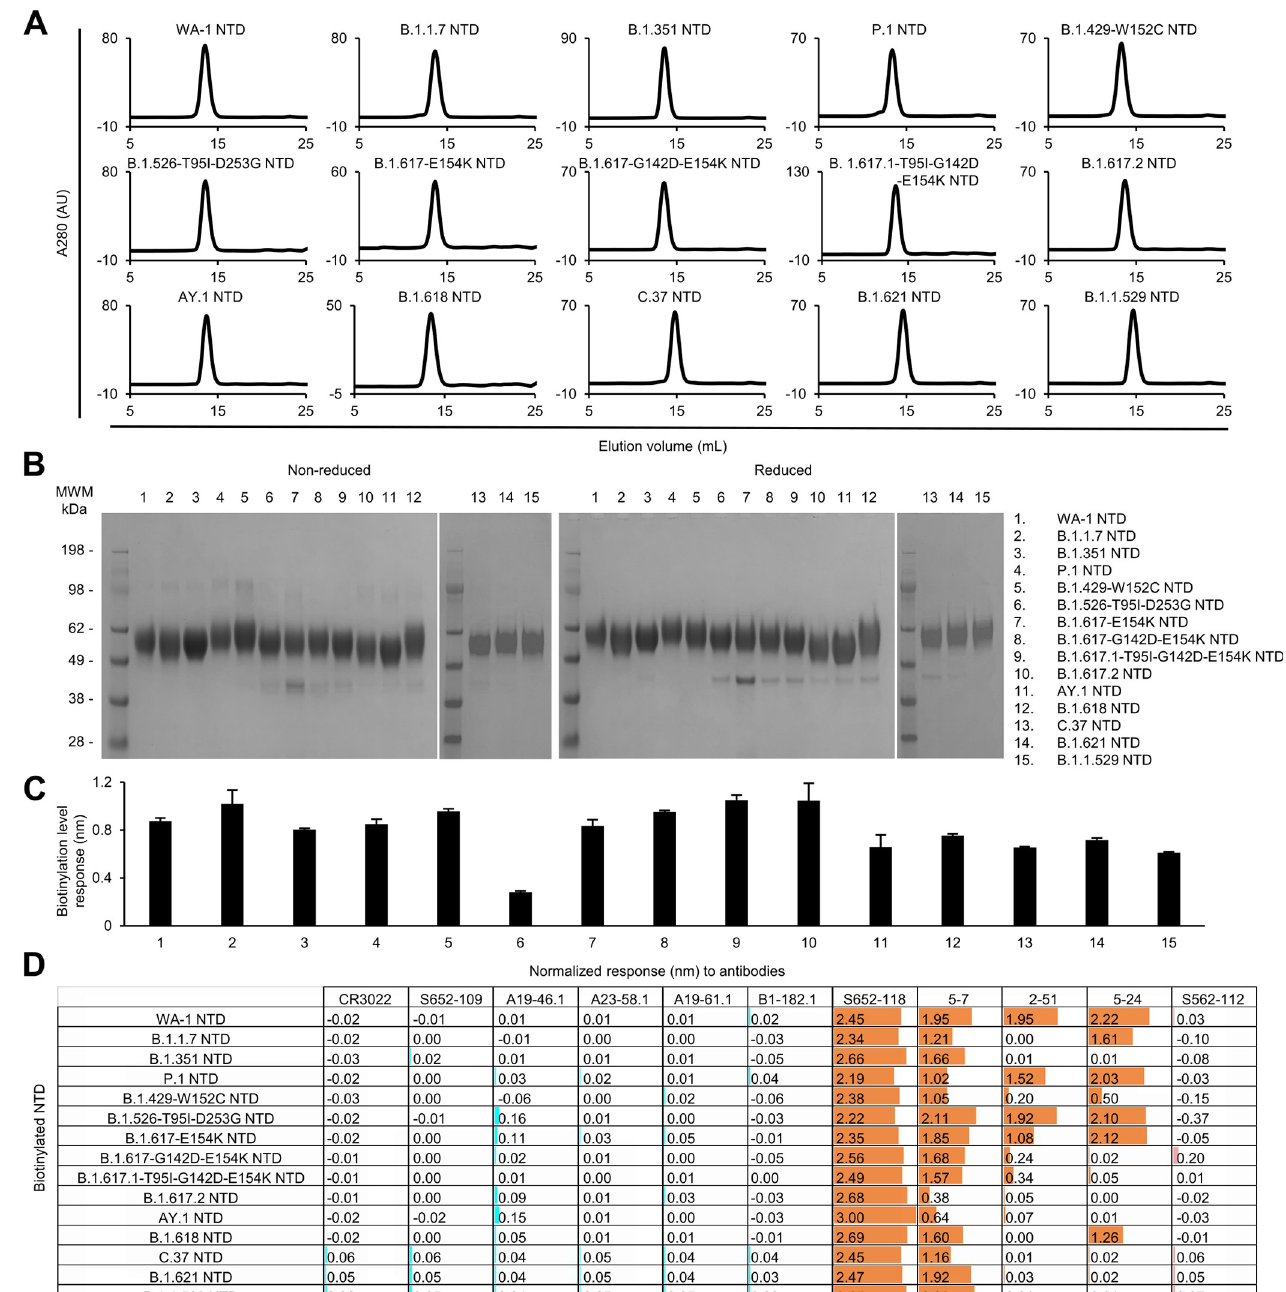
Fig 5. Characterization of biotinylated SARS-CoV-2 variant NTD probes confirms their homogeneity and antibody-binding specificity. (A) Size exclusion chromatography of purified biotinylated SARS-CoV-2 NTD probes, including original WA-1 NTD and 14 other variant NTD in PBS buffer. (B) SDS-PAGE of SARS-CoV-2 NTD variant probes with and without reducing agent. Molecular weight marker (MWM) and the WA-1 NTD probe were run alongside the variant NTD probes. (C) Biotinylation of the SARS-CoV-2 variant NTD probes. The level of biotinylation was evaluated by capture of NTD probes at 5 μ g/ml onto streptavidin biosensors using Octet. Error bars represent standard deviation of triplicate measurements. (D) Antigenicity assessment of the SARS-CoV-2 variant NTD probes. Responses to RBD-directed, NTD-directed, and S2 subunit-directed antibodies were shown in cyan, orange, and rose, respectively. Bar scale between 0 and 3. Negative values not